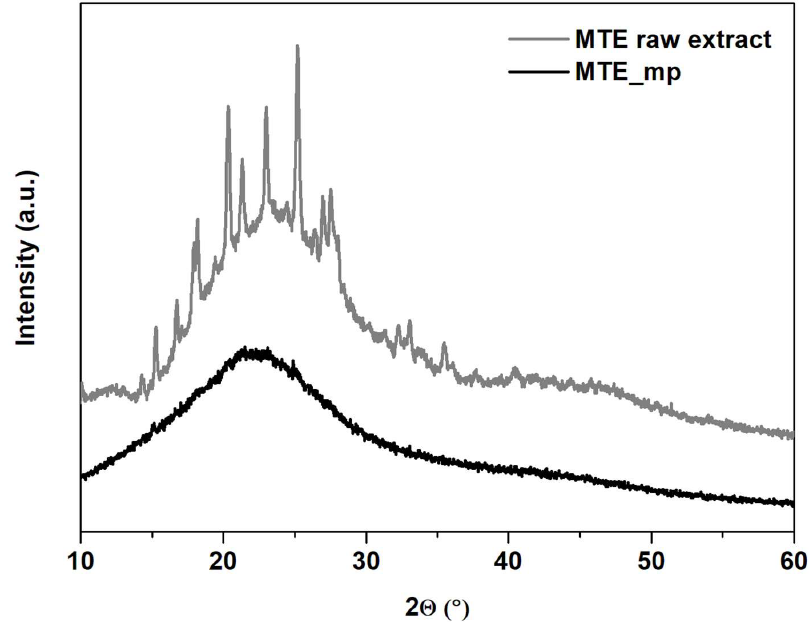
Figure 5. XRD analysis. Diffraction patterns of MTE raw extract (gray line) and MTE_mp (black line).